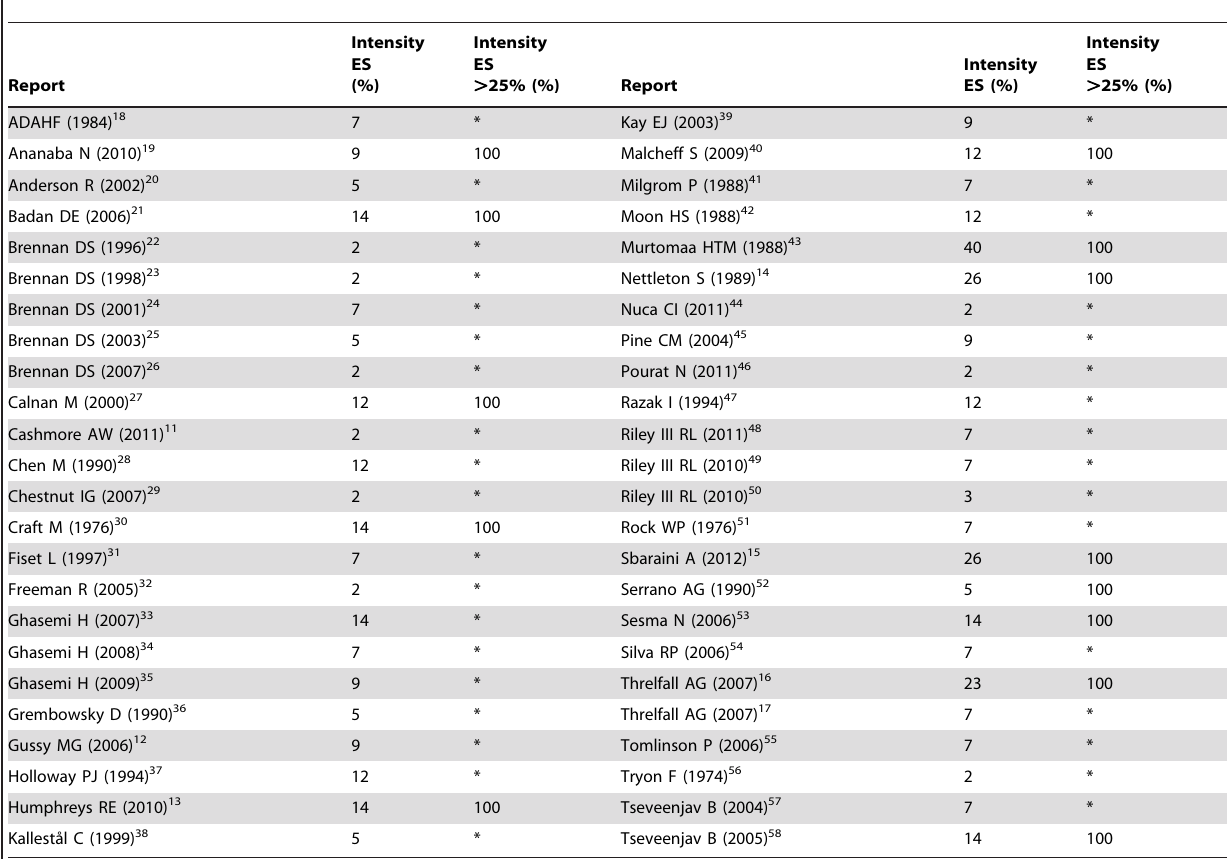
Table 4. Intensity effect sizes (ES) in relation to all themes and themes with frequency effects sizes .